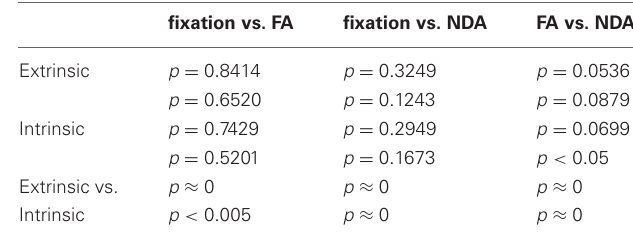
Table 2 | Statistical significance of average pairwise correlations.